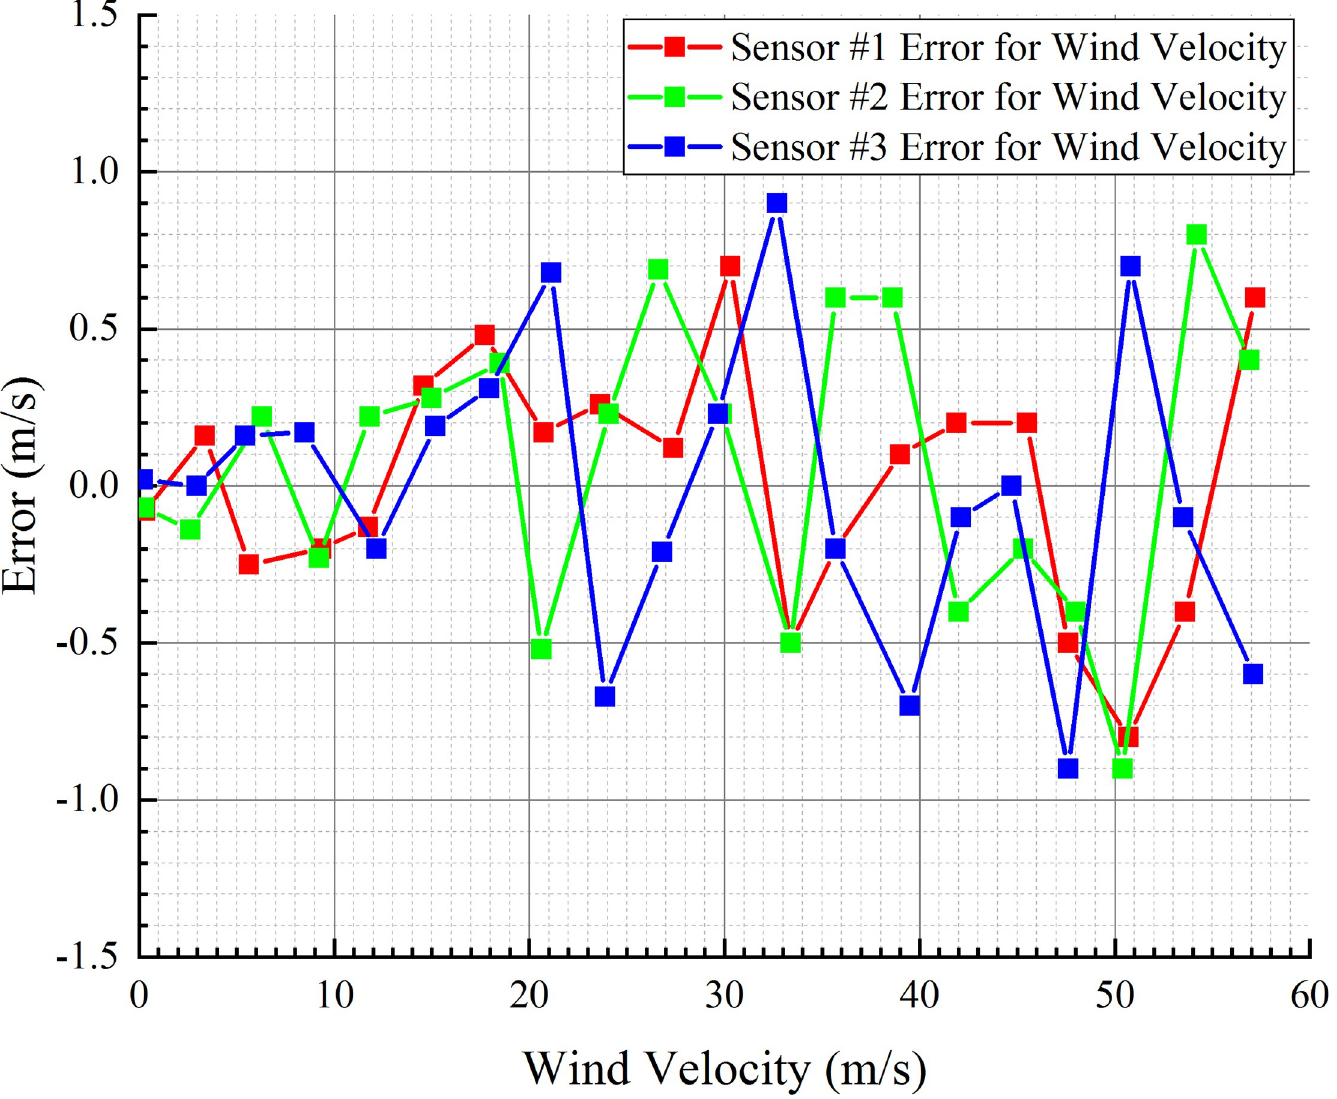
Fig 14. Error distributions of three